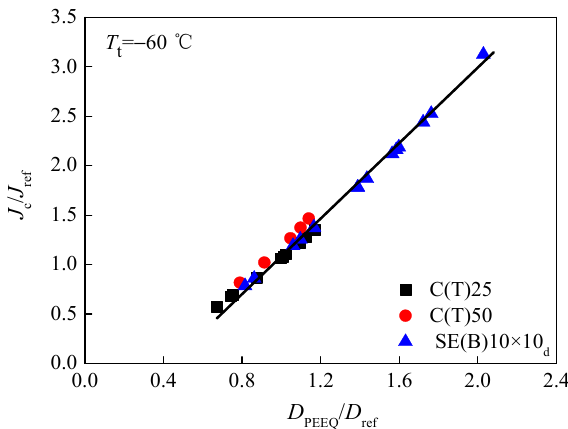
Figure 9. Relation between non-dimensional fracture toughness K Jc /K ref and constraint parameter D p .